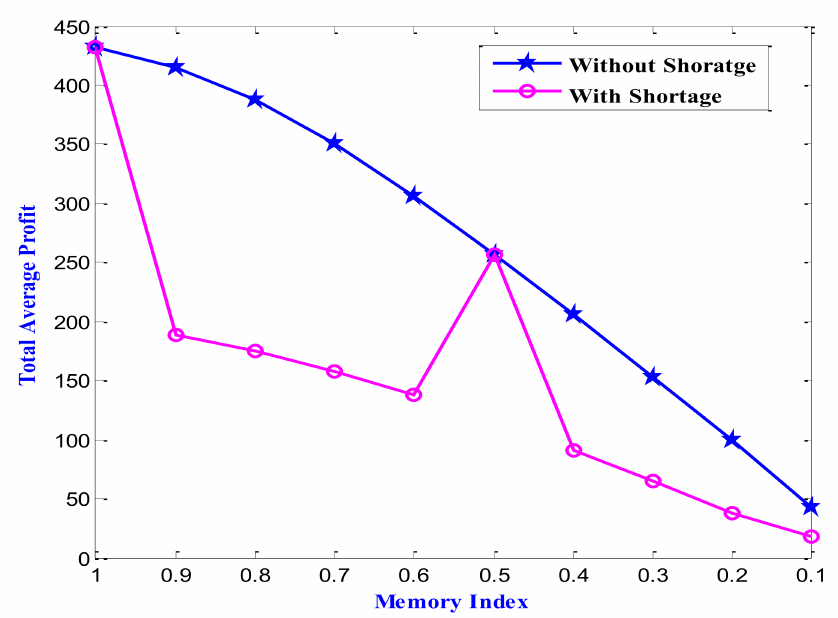
Figure 3. Impact memory on optimum values of the objective function total average profit ( TAP ∗ ) for the model with and without shortage (from left to right in the horizontal axis memory sense